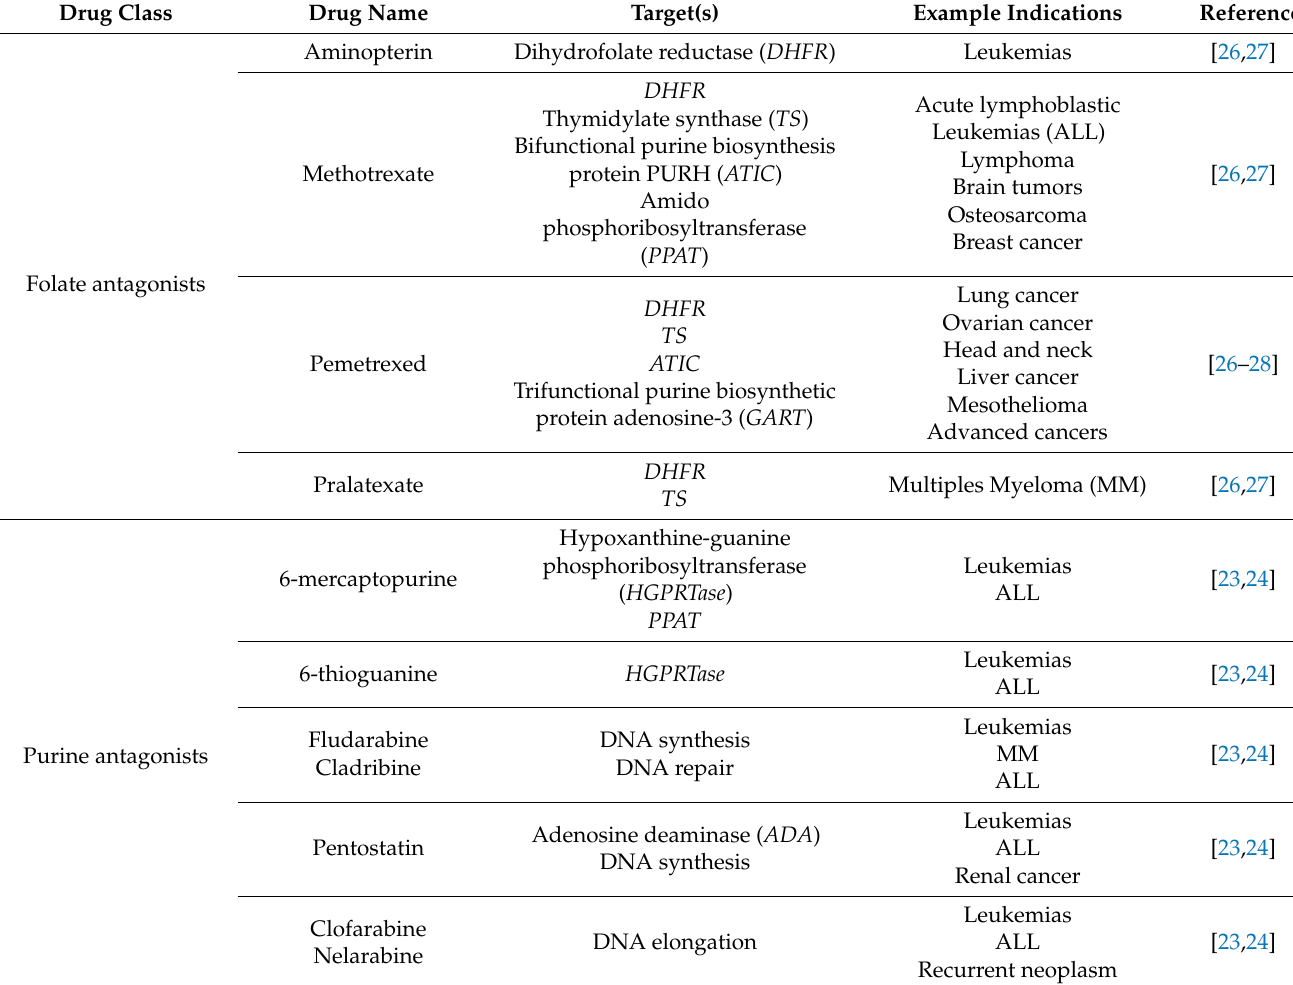
Table 1. Antimetabolites and mitochondria metabolic-targeting drugs to treat malignancies. Drug Class Drug Name Target(s) Example Indications